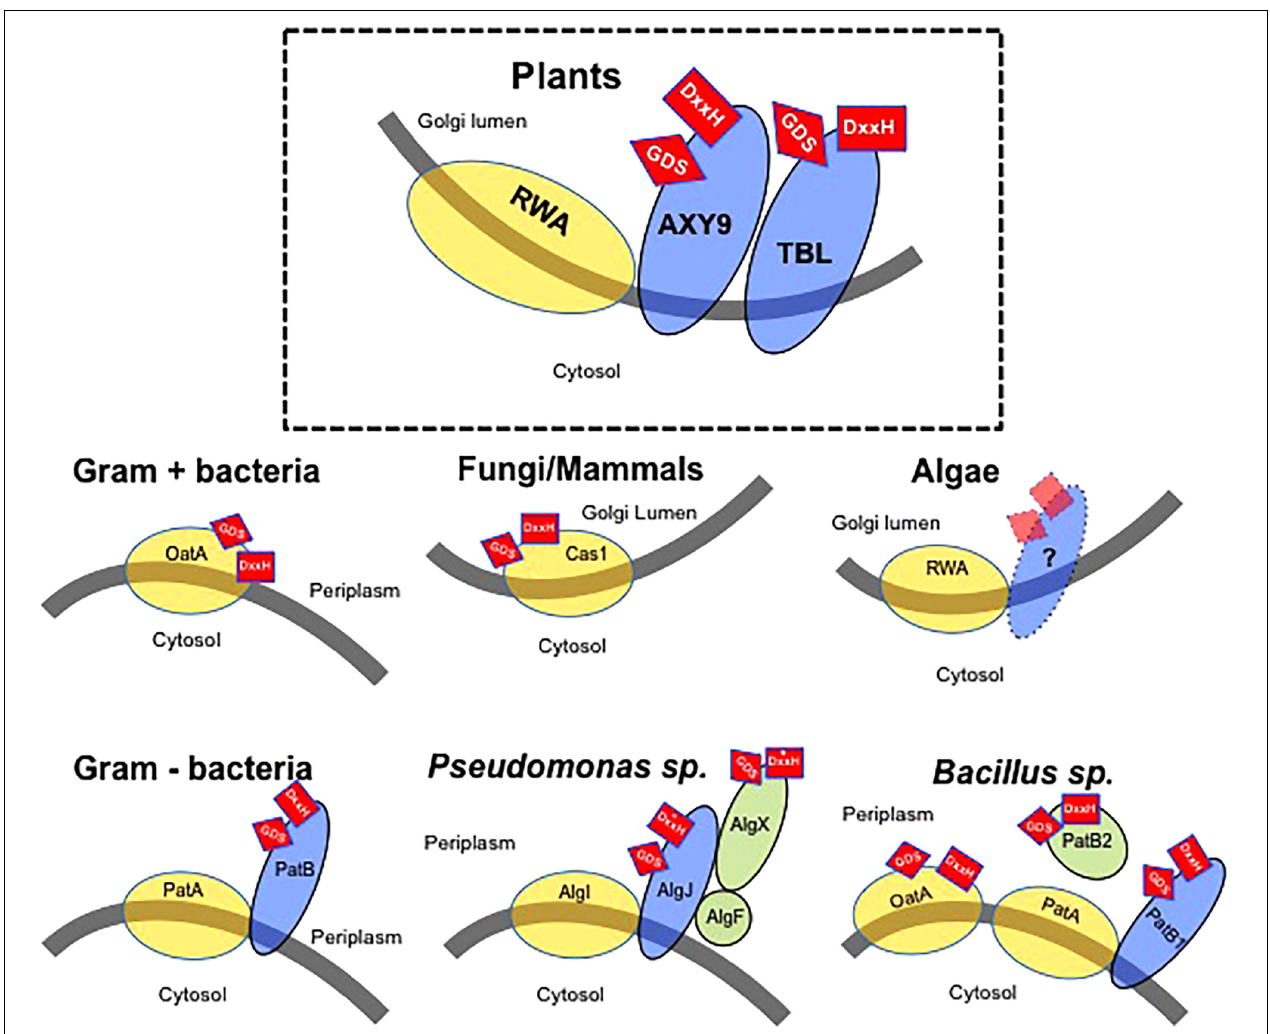
FIGURE 1 | Model of the wall polysaccharides O -acetylation mechanism in various organisms. Gray line – Membrane with indication of cellular location of both sides of the membrane. Yellow circles – Proteins consisting of multitransmembrane domains possibly involved in the translocation of an acetyl-moiety. Blue ovals – Membrane anchored proteins with a single-transmembrane domain. Green circles – Soluble proteins associated with O -acetylation. Red squares – Presence of GDS and DxxH sequences thought to be required for enzymatic activity. The location of these sequences (side of the membrane) is indicated by their location on the protein(s). Asterisk indicates a variation of the consensus DxxH motif (Baker et al.,